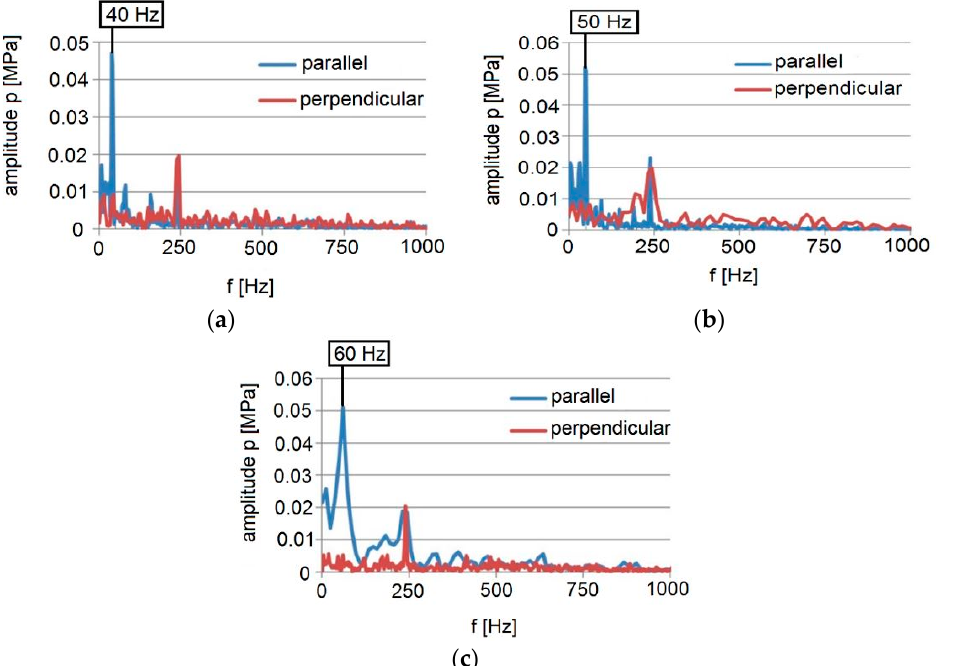
Figure 6. The amplitude-frequency spectrum of pressure pulsation in the system with vibrating proportional directional valve: ( a ) vibration frequency of the simulator table 40 Hz; ( b ) vibration frequency of the simulator table 50 Hz; ( c ) vibration frequency of the simulator table 60 Hz.